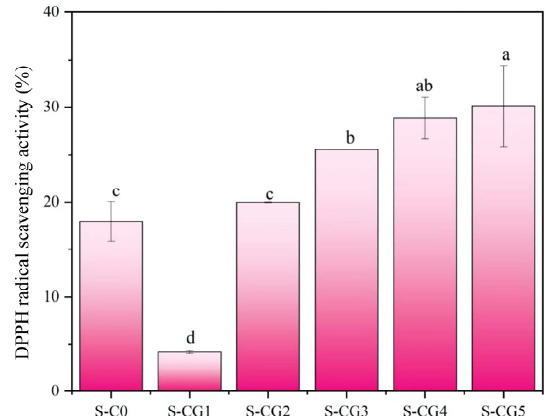
Figure 9. The DPPH free radical scavenging activities of composite films. Results are expressed as average, and different letters (a–d) indicate significant differences ( p < 0.05).